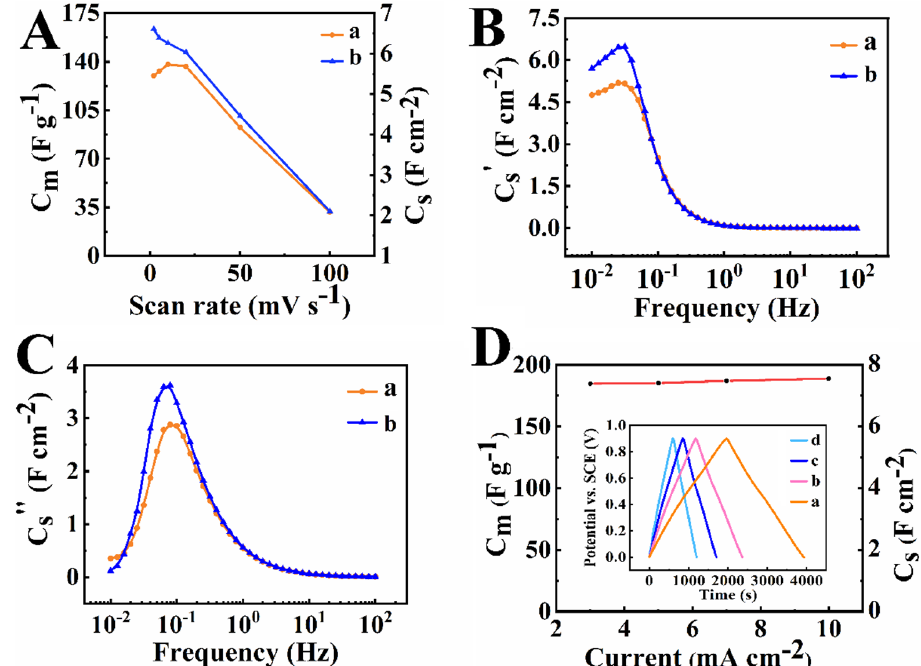
Figure 7. ( A ) Integral capacitances calculated from the CV data, ( B ) real and ( C ) imaginary components of differential complex capacitances versus frequency, calculated from the EIS data for (a) TP 1, (b) TP 3; ( D ) integral capacitance obtained from the GCD data after TP 5 versus current density; inset shows corresponding charge discharge curves for current densities of (a) 3, (b) 5, (c) 7, and (d) 10 mA cm − 2 .